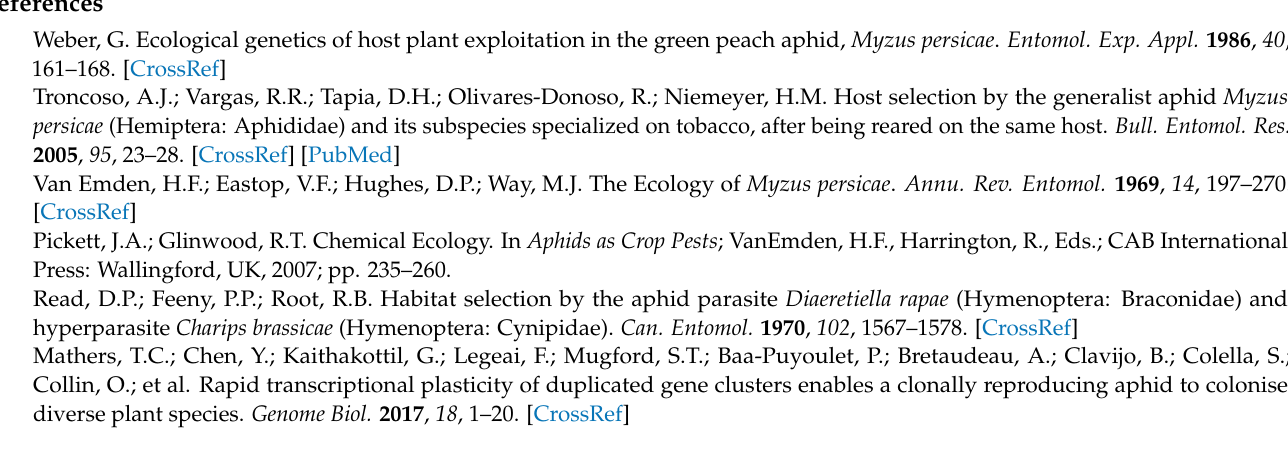
levels of MperORs . Table S3: The protein names and sequences of 606 ORs from 7 species of insects used in Figure S3. Table S4: The protein names and sequences of 298 ORs from 5 different species used in Figure 1. Table S5: A percent identity matrix of MperORs. Table S6: A percent identity matrix between MperORs and DmelORs. Table S7: A percent identity matrix between MperORs and AgosORs. Table S8: A percent identity matrix between MperORs and ApisORs. Figure S1: The stable expression of M. persicae β -actin and GAPDH in different tissues measured by RT-qPCR. Figure S2: The standard curves of MperORs with GAPDH as reference gene. Figure S3: Phylogenetic tree of 606 ORs from 7 species of